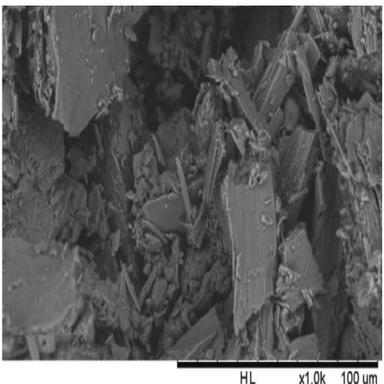
Scanning electron microscope (SEM) observation of a sintered magnesitebased ceramic at 1300 C.